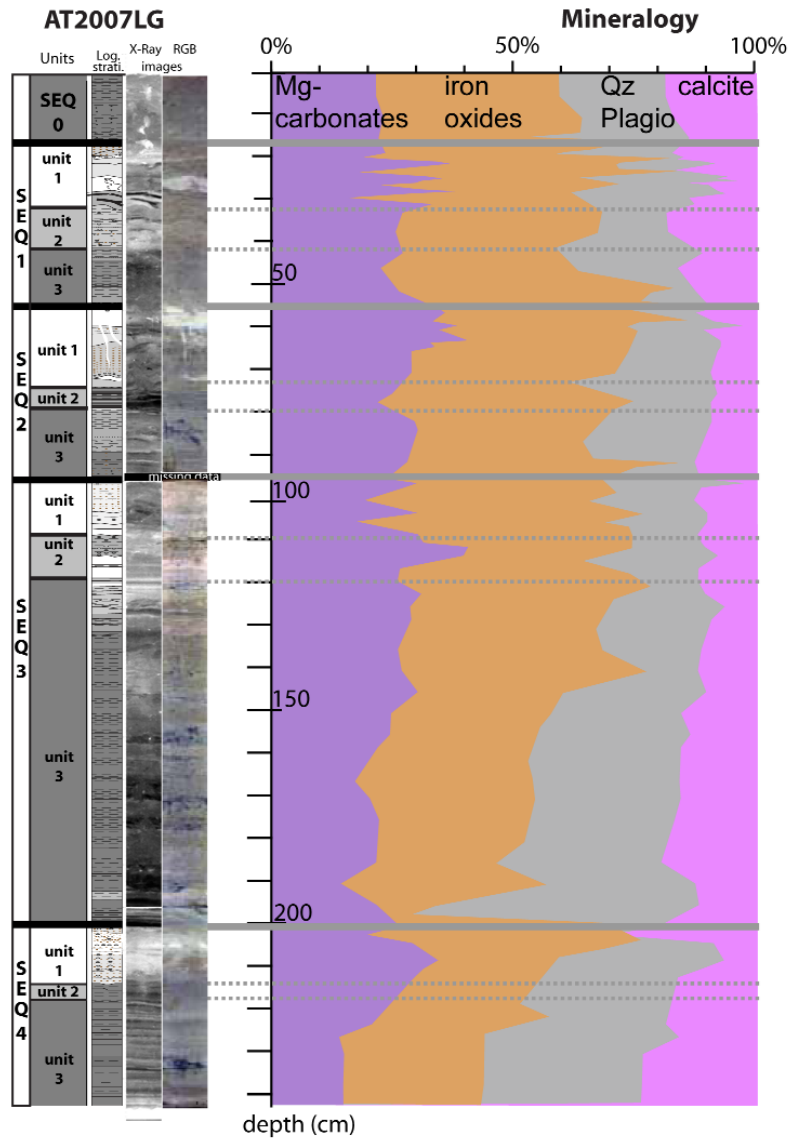
Figure 8. The 2.5-m-long AT2007LG core and mineralogical changes. From right to left: Division in three units of the four sequences of the core; detailed stratigraphic log; X-ray images; photographs of the core; XRD mineralogical changes with iron oxide, Mg-carbonate, quartz+plagioclase, calcite (quantification excluding clay